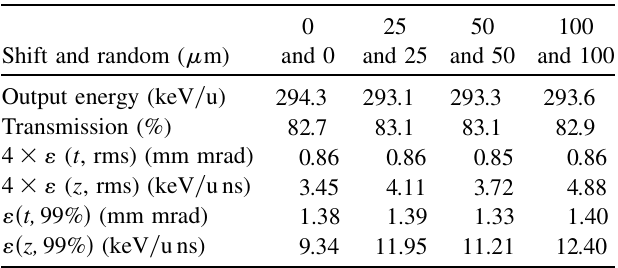
TABLE XI. Combined effect of global shifts and random vane modulation errors with increasing amplitudes.